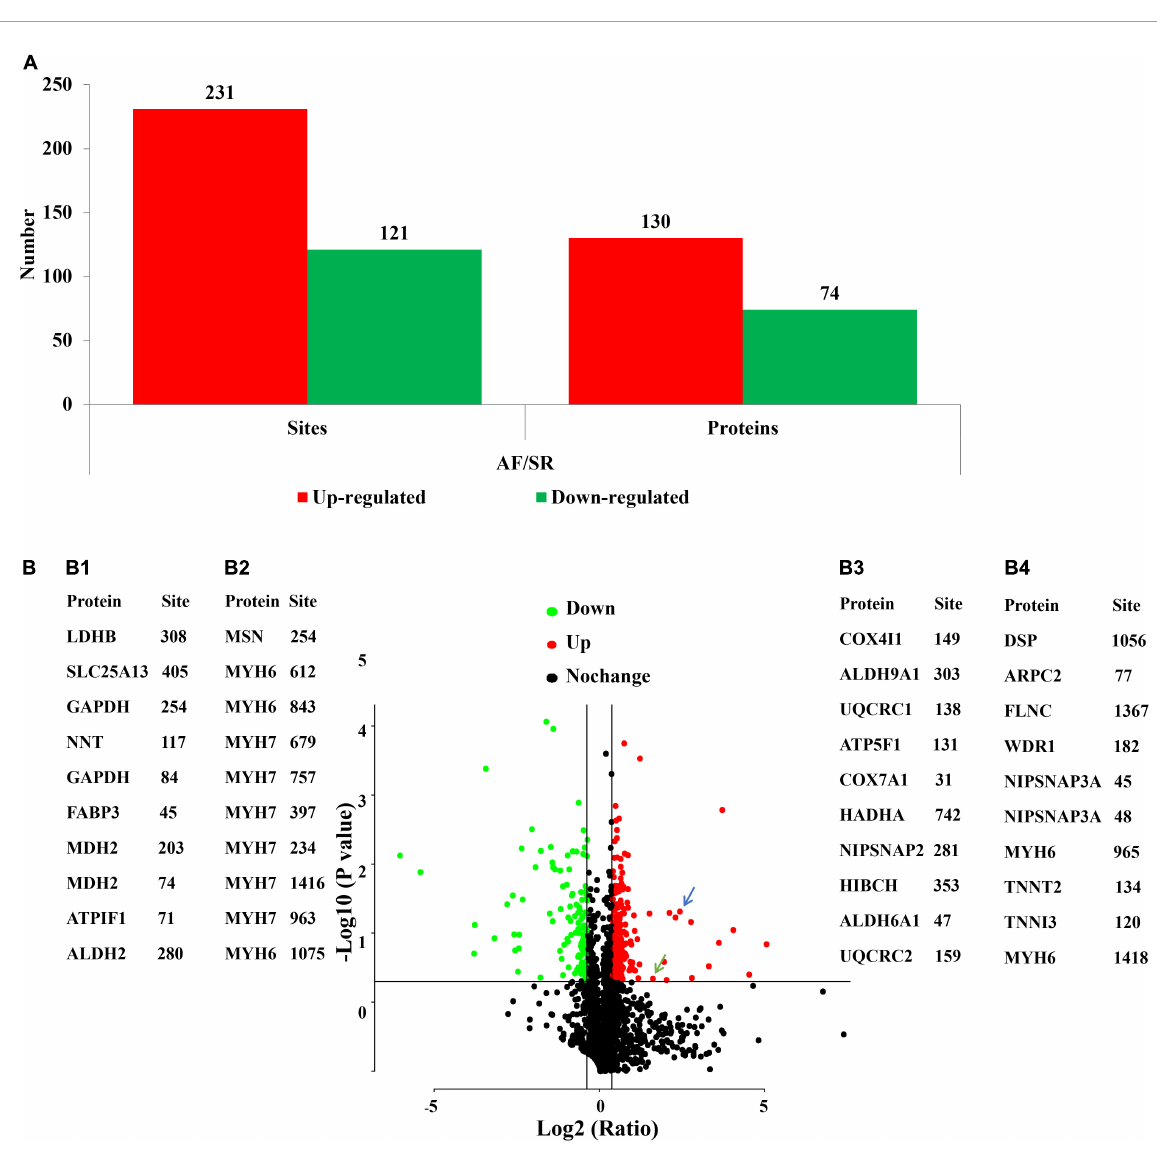
2 Kac protein abundance